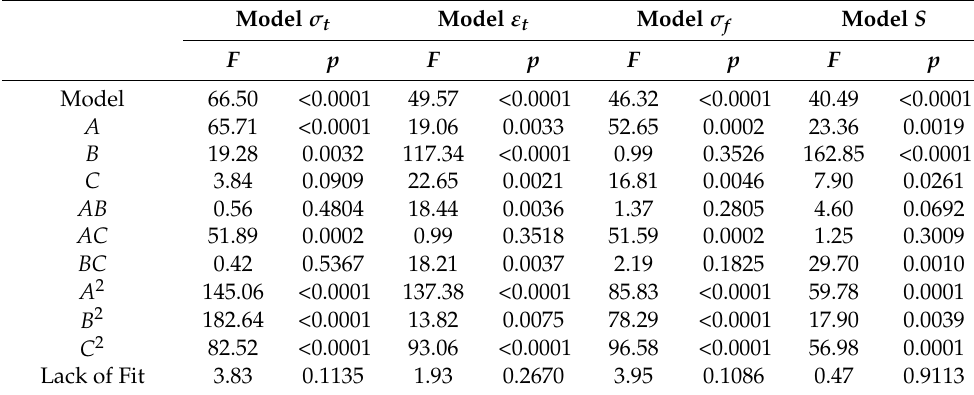
Table 3. Results of ANOVA of response surface